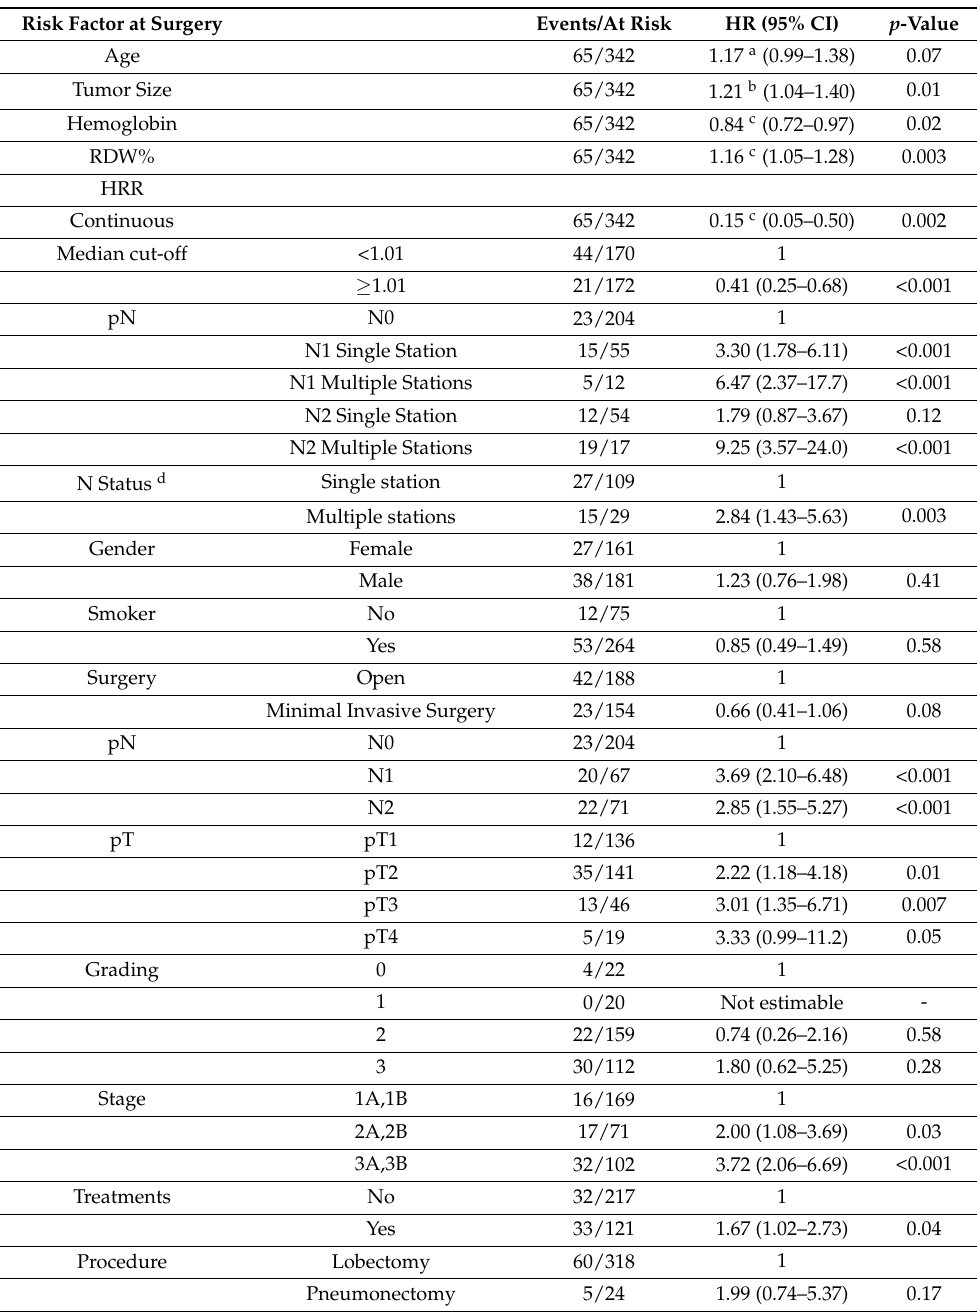
Table 2. Disease-free survival univariate